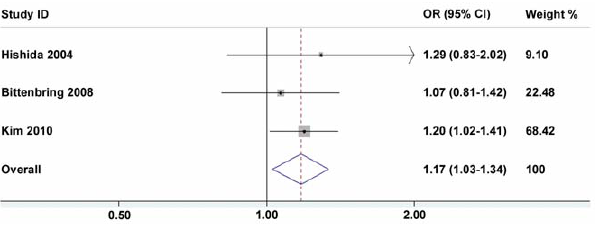
Figure 3. Forest plots of dominant model (Arg/Pro + Pro/Pro vs. Arg/Arg) in different subgroups. The squares and horizontal lines correspond to OR and 95% CI of specific study, and the area of squares reflects study weight (inverse of the variance). The diamond represents the pooled OR and its 95% CI.